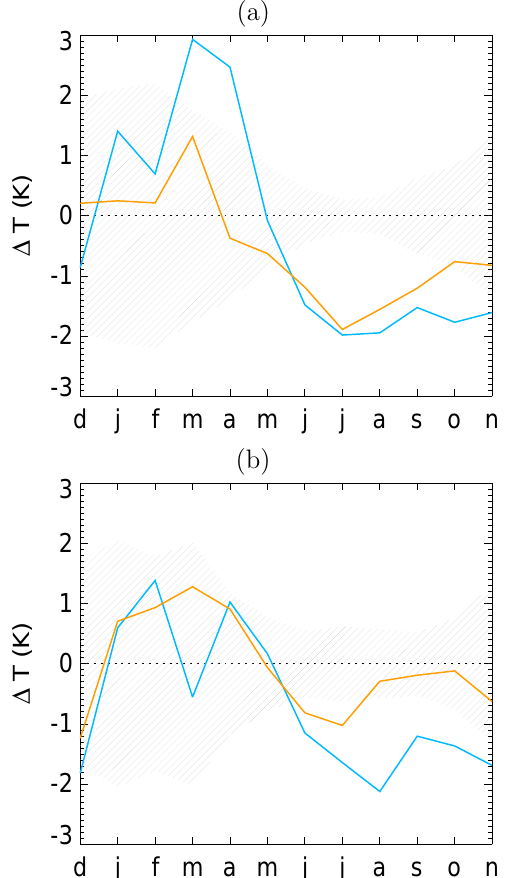
Fig. 4. Area-average difference in (a) Laurentia and (b) Fennoscan- dia of surface air temperature between incipient glacial and re- cent monthly climatology as simulated by FAMOUS (blue) and HadSM3 (orange) (IG minus recent). Hatching indicates statisti- cally insignificant differences.